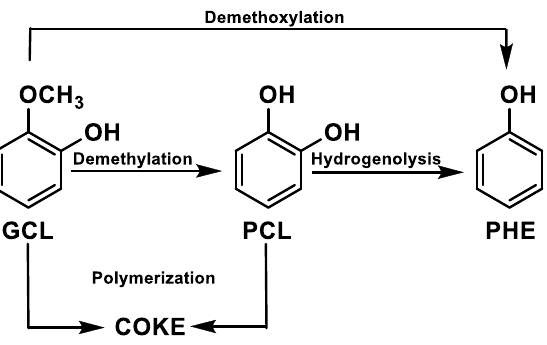
Figure 5. Guaiacol reaction path.